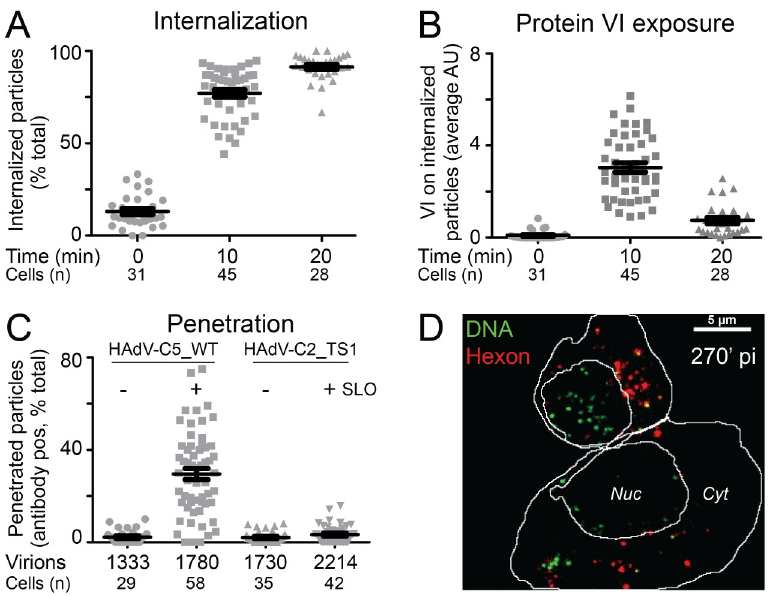
Fig 4. Characterization of HAdV-C5 entry into MPI-2 cells. A) Internalization of HAdV-C5 into MPI-2 cells and B) exposure of viral membrane lytic protein VI on internalized virus. Atto565-labeled HAdV-C5 were added to MPI-2 cells at 4˚C (moi ~13600 virus particles per cell) for 60 min. Unbound particles were washed away, and cells were shifted to 37˚C for the indicated times. Intact cells were then incubated with 9C12 anti-hexon antibodies at 4˚C to tag surface-associated viruses, and after fixation, cells were permeabilized and stained for protein VI. Secondary Alexa Fluor680-conjugated anti-mouse and Alexa-Fluor488-conjugated anti-rabbit antibodies were used to detect 9C12 and anti-protein VI antibodies, respectively. Nuclei were stained with DAPI, and samples were imaged by confocal microscopy. Virus particles lacking the 9C12 signal were scored as internalized particles and (A) shows percentage of internalized virus particles per cell at the different time points. One dot represents one cell. (B) shows mean average protein VI signal on internalized particles. One dot represents one cell. Error bars represent the means ± SEMs. Number of cells analyzed is indicated. C) SR-A6-facilitated entry supports efficient penetration of HAdV-C5 into the cytoplasm. Alexa-Fluor488-conjugated HAdV-C5 were added to MPI-2 cells at 4˚C for 60 min (moi ~7300 virus particles per cell). Unbound viruses were washed away and cells were shifted to 37˚C for 45 min. Cell surface and cytoplasmic particles were tagged with anti-Alexa-Fluor488 antibodies after perforation of the plasma membrane with streptolysin O (SLO). The anti-Alexa-Fluor488 antibodies in turn were visualized by secondary Alexa-Fluor594 antibodies. Control cells were incubated with antibodies without SLO treatment to specifically mark virus particles at the plasma membrane. The plot shows percentage of virus particles positive for the anti-Alexa-Fluor488 antibodies, one dot representing one cell. The majority of antibody-positive particles in the SLO-treated HAdV-C wild type (wt) sample represent cytoplasmic virus, since the no-SLO control indicated only few particles at the cell surface. Virus particles in the endosomes are inaccessible to the antibodies, and the endosomes stayed intact in the assay, since parallel samples infected with the penetration deficient HAdV-C2-TS1 mutant virus displayed only low number of antibody-positive particles. Error bars represent the means ± SEMs. Numbers of cells and virus particles analyzed are indicated. D) Tracking of incoming virus genome. EdC-labeled HAdV-C5 particles (moi ~ 7300 virus particles per cell) were internalized into MPI-2 cells at 37˚C for 30 min and, after removal of unbound virus, the samples were incubated for further 270 min before fixation. The virus capsids were visualized by anti-hexon 9C12 and Alexa- Fluor594-conjugated secondary antibodies, and click-reaction with Alexa-Fluor488-conjugated azide was carried out to mark the virus genomes. The image represents maximum projection of image stack from central parts of the cells. Nuclear area and cell outline are indicated. In the majority of cells, the virus genome was separated from the capsid at this time point and concentrated over the nuclear area, as exemplified by the upper cell in the image. A fraction of cells displayed significant amounts of capsid-free virus DNA also in the cytoplasm, as exemplified by the lower cell in the image. Scale bar = 5